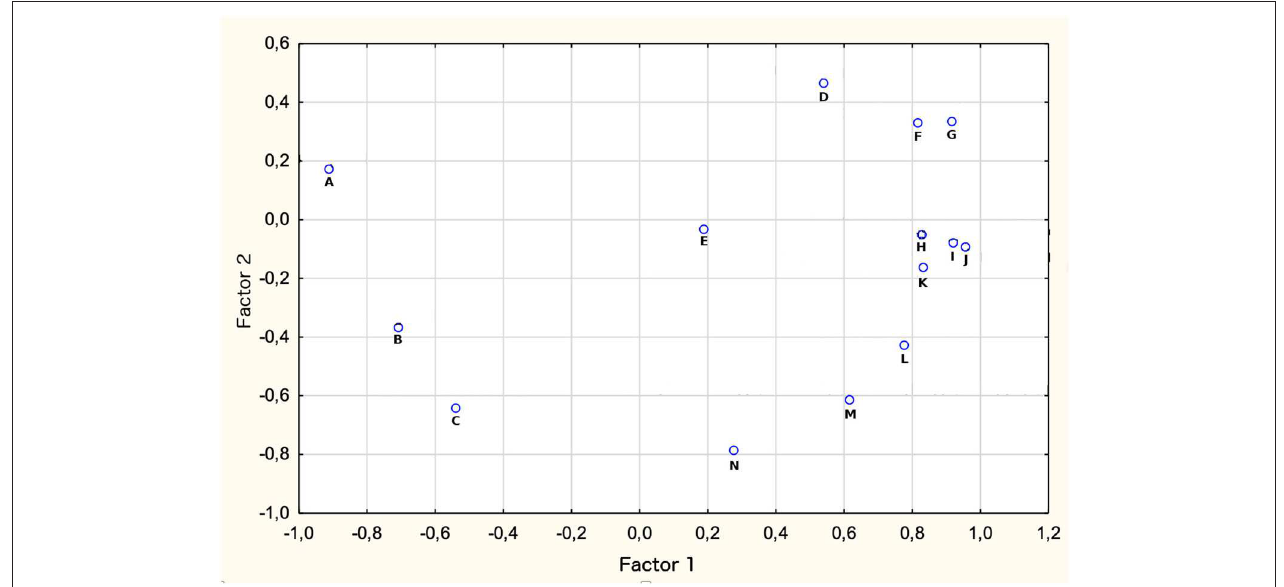
FIGURE 2 | Correlation between health system performance and economic factors. Results for Factor analysis. A, Agriculture share in GDP (%); B, GDP growth; C, Industry share in GDP (%); D, Unemployment; E, Inflation rate; F, Health expenditures (% of GDP); G, Services share in GDP (%); H, Health expenditures per capita; I, Health Expenditures per capita (Purchasing Power Parity); J, Government expenditures on health (% of GDP); K, Government expenditures on health (% of total government expenditures); L, GDP per capita; M, government expenditure (% of total health expenditure); N, synthetic measure of health system